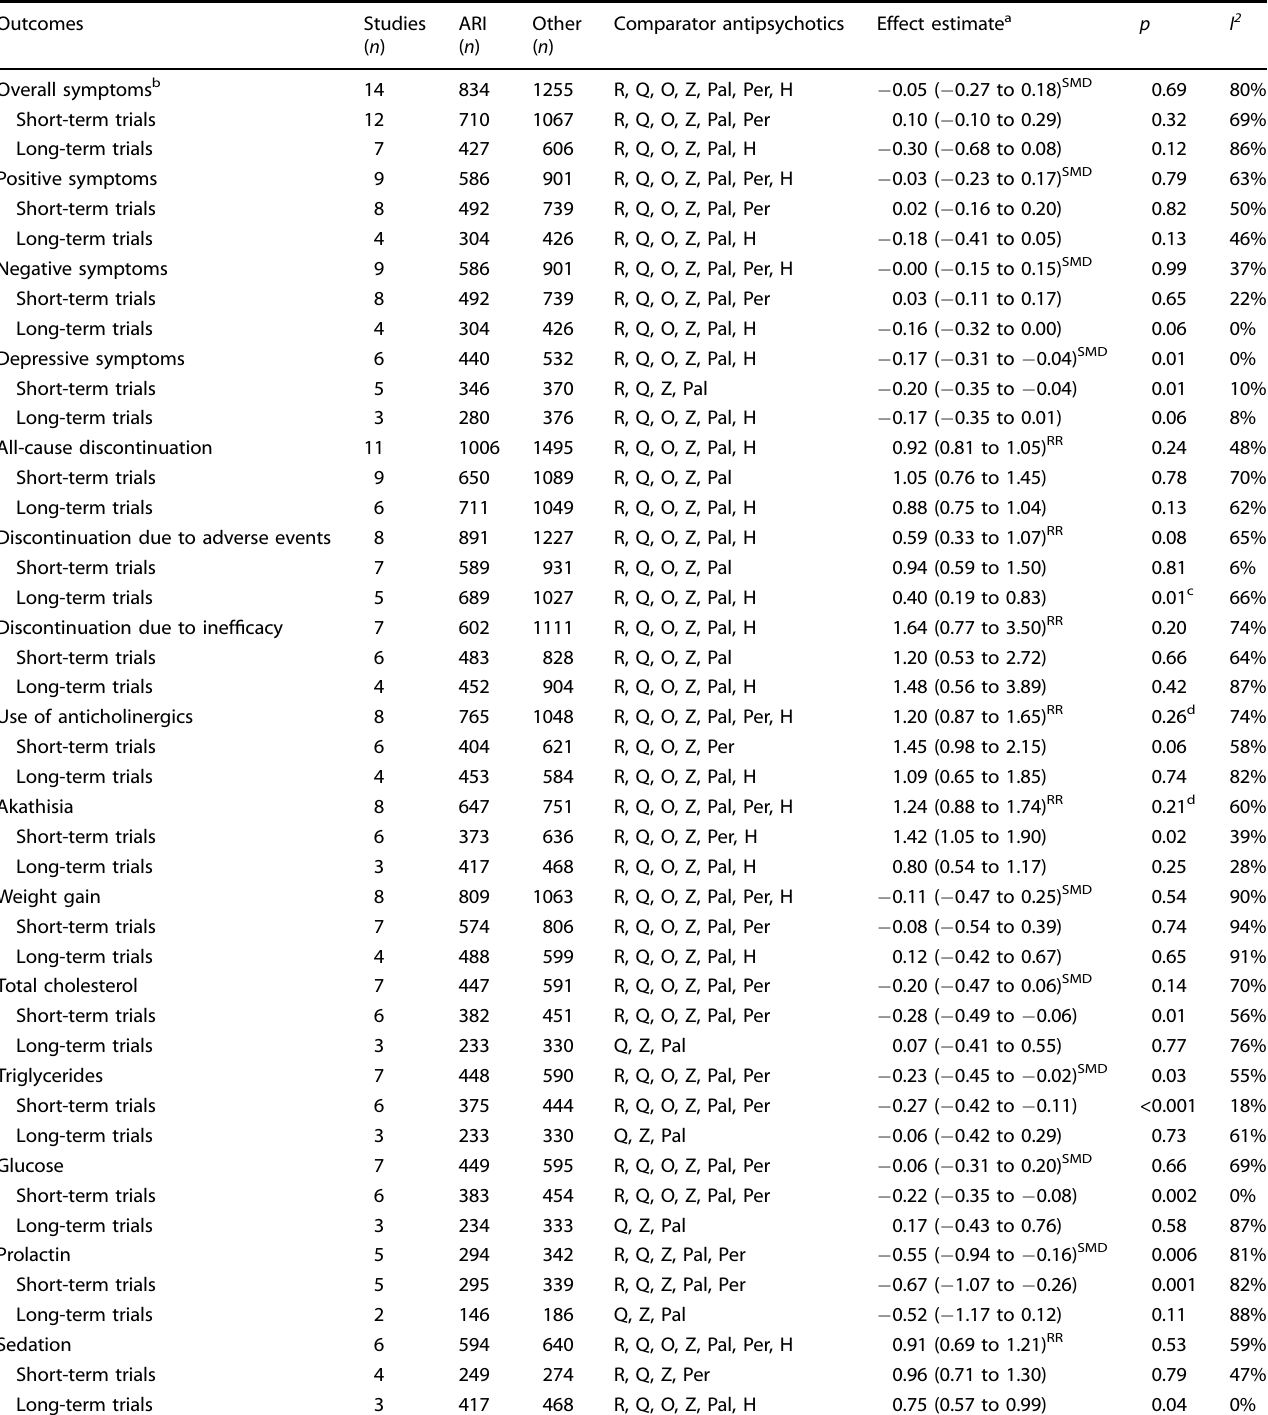
Table 2. Comparisons of aripiprazole with D 2 R antagonists in the early course of